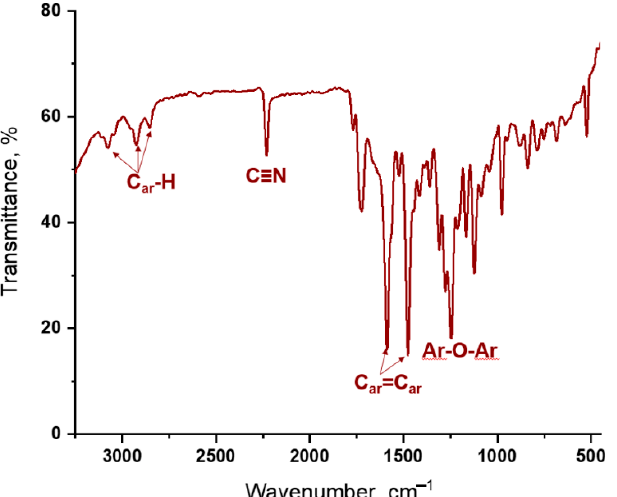
Figure 3. FT-IR spectrum of bistetrakis-4-[3-(3,4-dicyanophenoxy)-phenoxy]phthalocyaninato ytterbium ( 5 ).